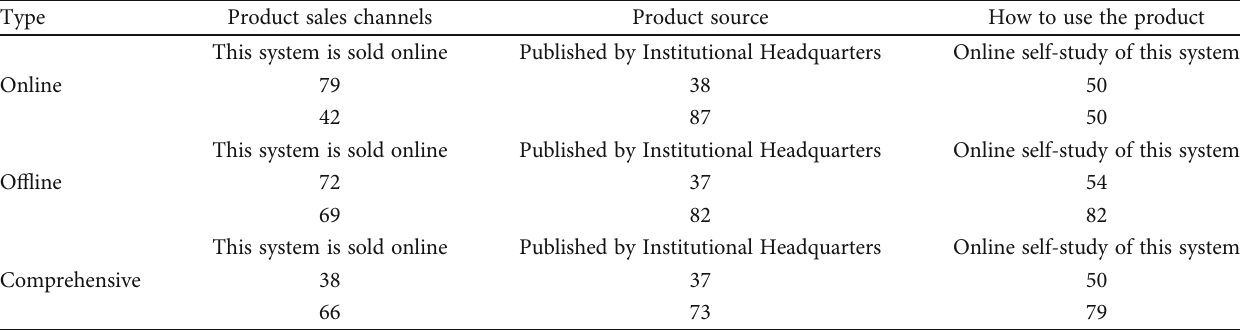
Table 2: Table of product types of educational